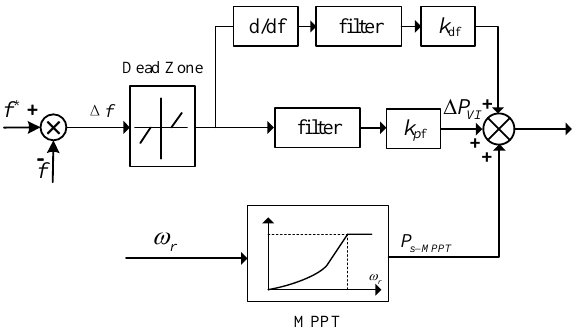
Figure 3. Schematic diagram of the accessional power outer-loop control.